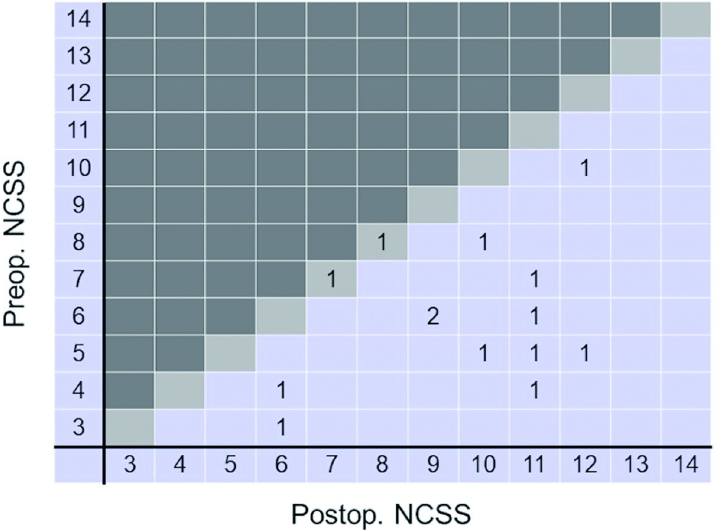
Fig 6. The improvement in the neurosurgical cervical spine scale (NCSS) scores of patients aged � 80 years. Postoperatively, the majority of patients scored up to 9 points. None of the patients achieved a full score (14 points) postoperatively. Most patients, however, did recover to some extent following surgery. Postop., postoperative; Preop., preoperative.